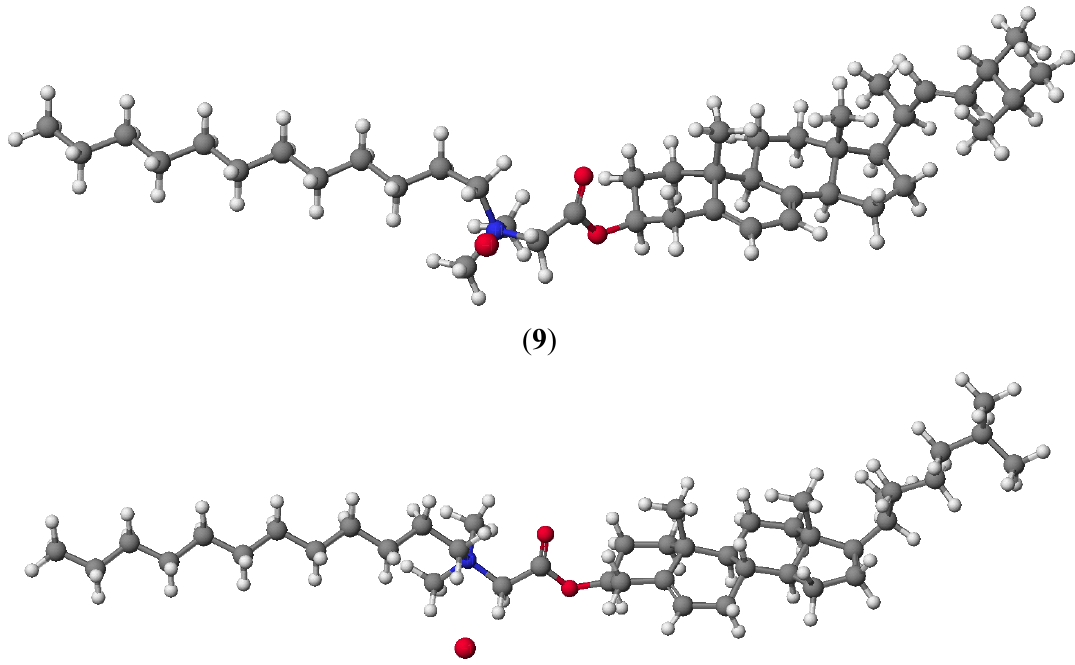
Figure 7. Molecular models of representative compounds ( 9 ), ( 13 ) and ( 17 ) calculated by PM5